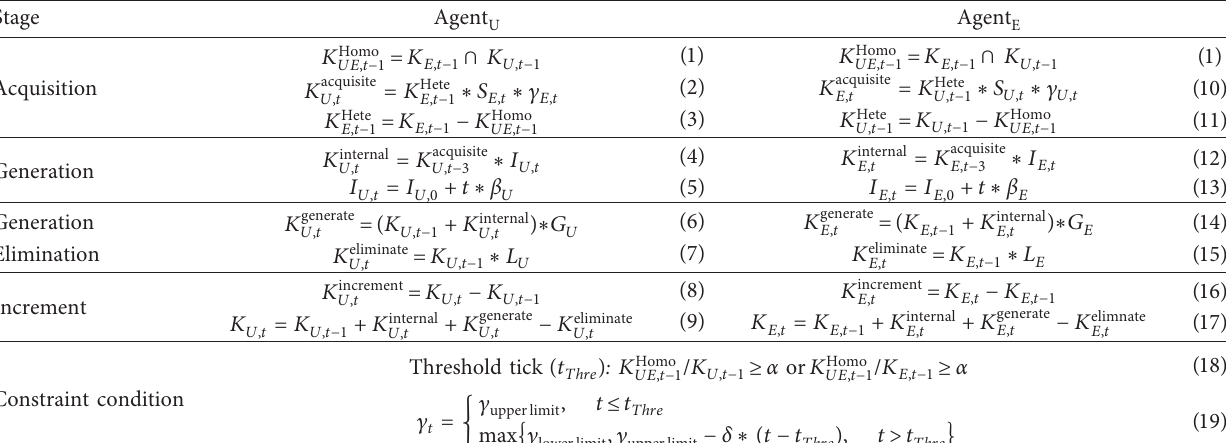
Table 2: Agents’ behavior